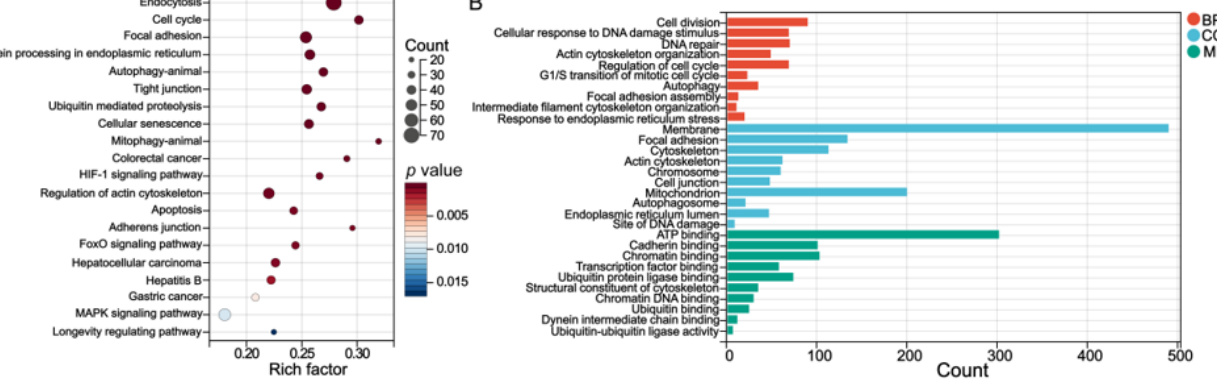
Figure 4. ( A ) The KEGG enrichment pathways and ( B ) GO terms of 2289 overlapped genes of DEGs and differentially m6A-methylated